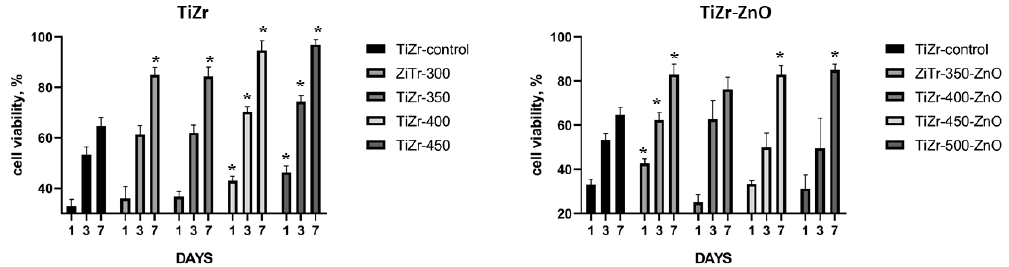
Figure 9. Resazurin reduction assay of U2OS cells cultured on TiZr substrate after PEO in Ca(H 2 PO 2 ) 2 bath and with ZnO NPs. (*—significant di ff erence ( p ≤ 0.05) between PEO coated samples and polished